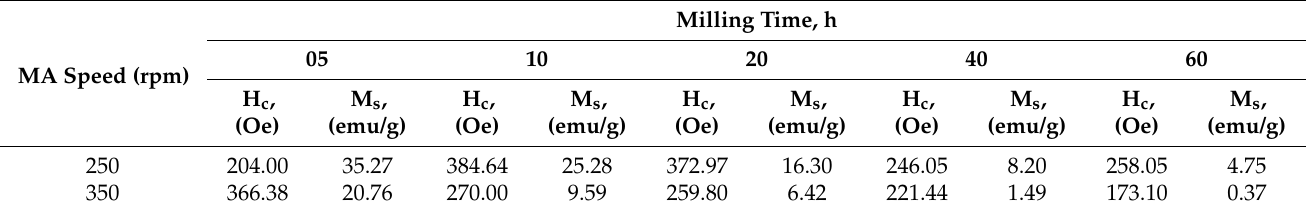
Figure 5. Hysteresis curves of the powders milled for 5, 10, 20, 40 and 60 h ( a ) at 250 rpm and ( b ) at 350 rpm. Table 3. M s and H c values obtained from VSM analyses of Al 82 Fe 14 Ni 4 alloys milled for different times at 250 and 350 rpm.